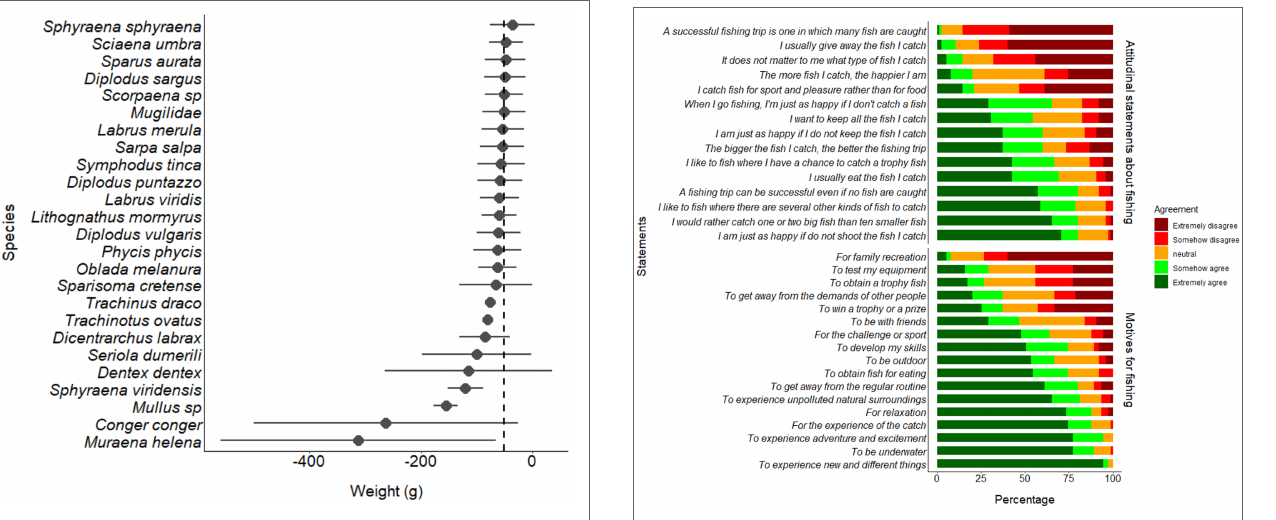
FIGURE 7 | Attitudes towards catching fish and motive statements for fishing among Italian spearfishers that participated to at least one final or semifinal tournament of the national championship during the period 2017- 2019. Percentage of replies according to a Likert scale is showed for each statement (N =